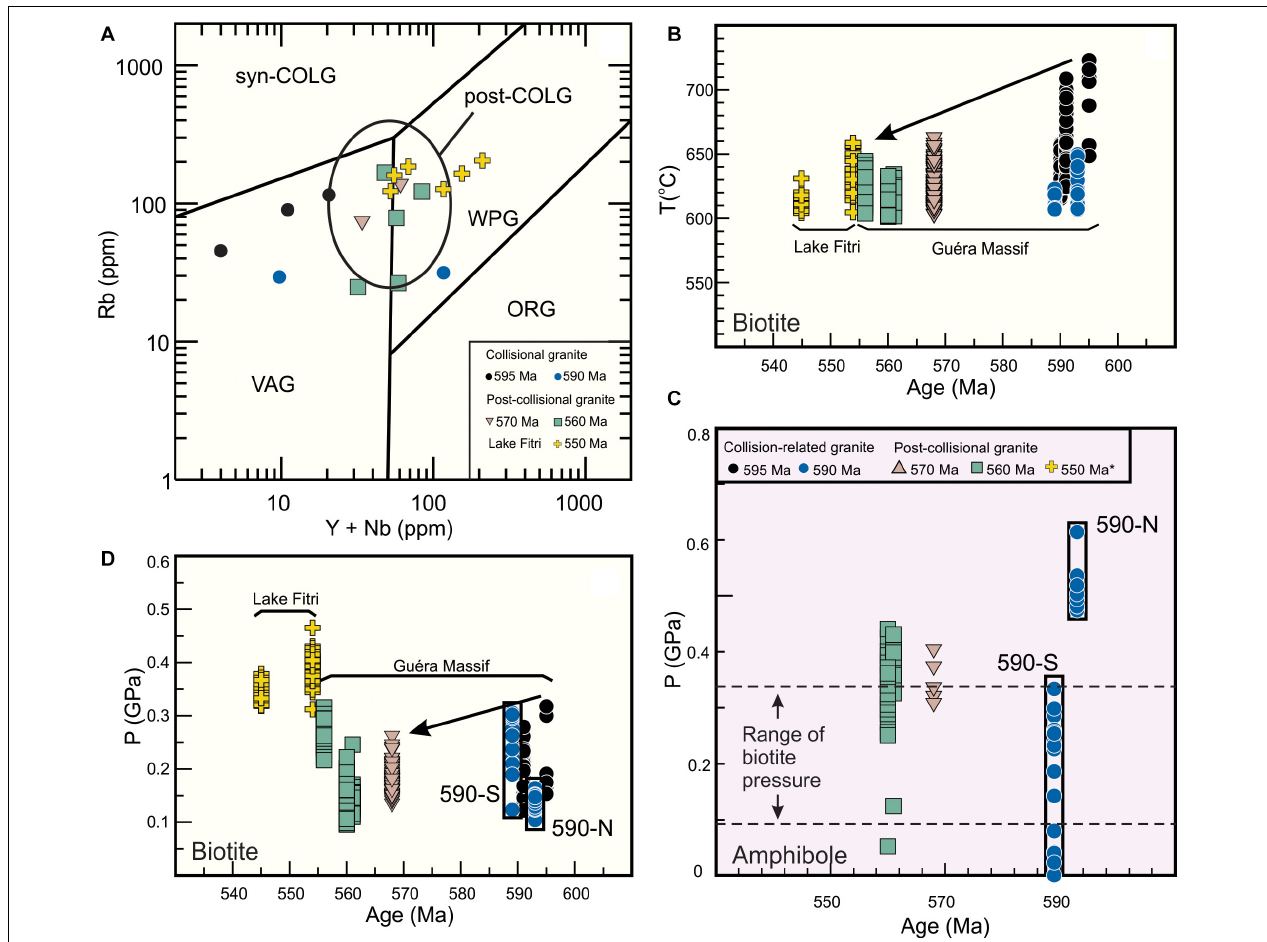
FIGURE 7 | (A) Classification of granitic rocks using Rb (ppm) vs Y + Nb (ppm) of Pearce (1996). Syn-COLG = syn-collisional granite, WPG = within-plate granite, VAG = volcanic-arc granite, ORG = ocean-ridge granite, post-COLG = post-collisional granite. (B) Biotite crystallization temperature estimates of the Guéra Massif and Lake Fitri granites. Crystallization pressure estimates of (C) amphibole, and (D) biotite of the Guéra Massif and Lake Fitri